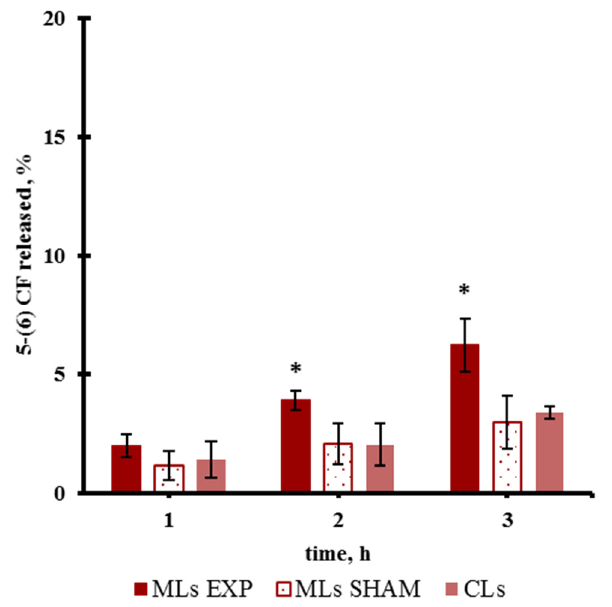
Figure 6. Release from Liquid Order MLs and CLs during PEMFs exposure and SHAM condition. (*) p < 0.05.